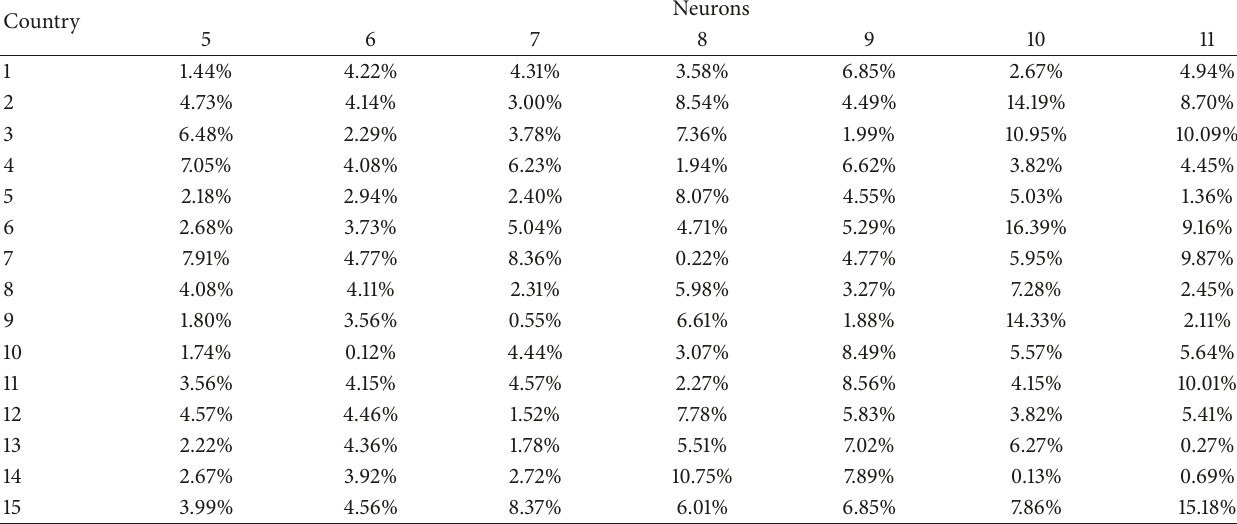
Table 9: Europe model error corresponding to the number of neurons in different hidden layers. Country